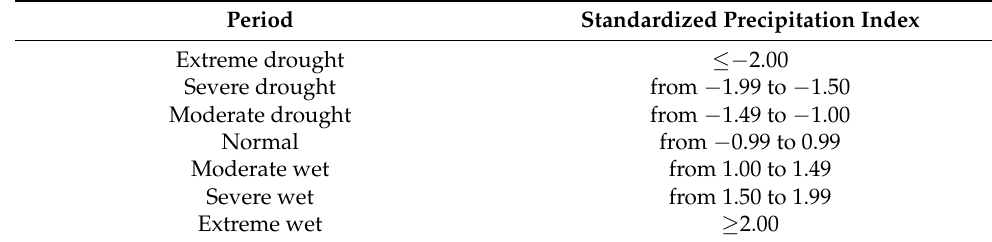
Table 2. Classification of the period as dependent on Standardized Precipitation Index values [24]. Period Standardized Precipitation Index Extreme drought ≤− 2.00 Severe drought from − 1.99 to − 1.50 Moderate drought from − 1.49 to − 1.00 Normal from − 0.99 to 0.99 Moderate wet from 1.00 to 1.49 Severe wet from 1.50 to 1.99 Extreme wet ≥ 2.00